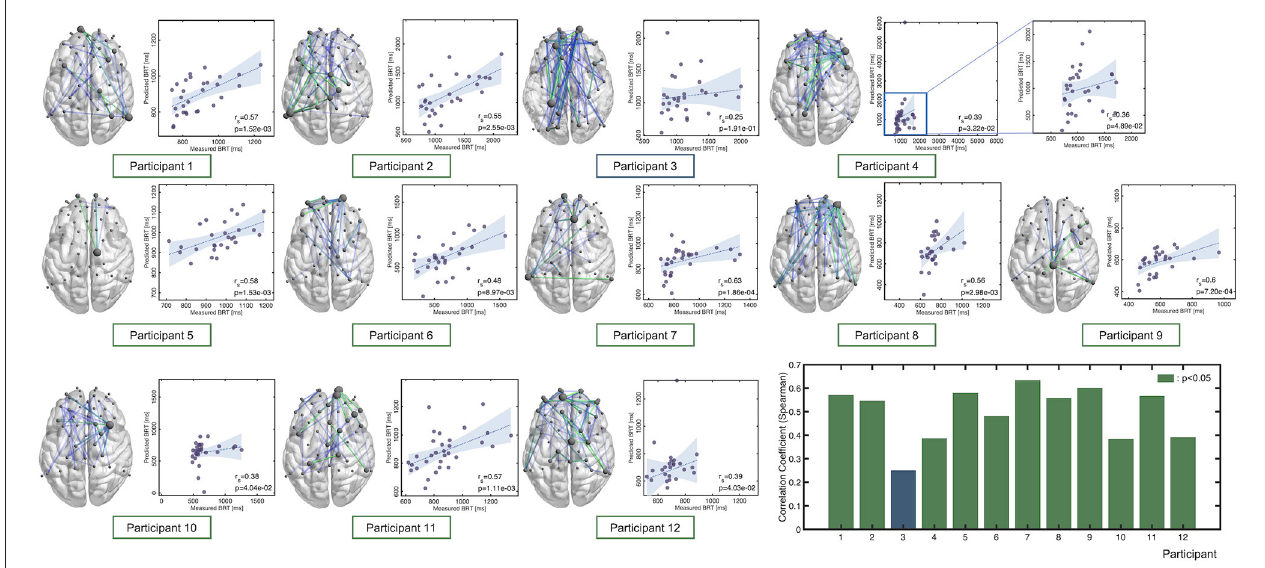
FIGURE 5 | Correlation between the predicted and measured BRTs for each participant. Note that the hyperparameters of these models were chosen based on the held-out test samples accuracy. Each connectome plot indicates the functional connectivity edges chosen via feature selection and used for the regression model. The bar graph summarizes Spearman’s correlation as an accuracy measure for each individual model.